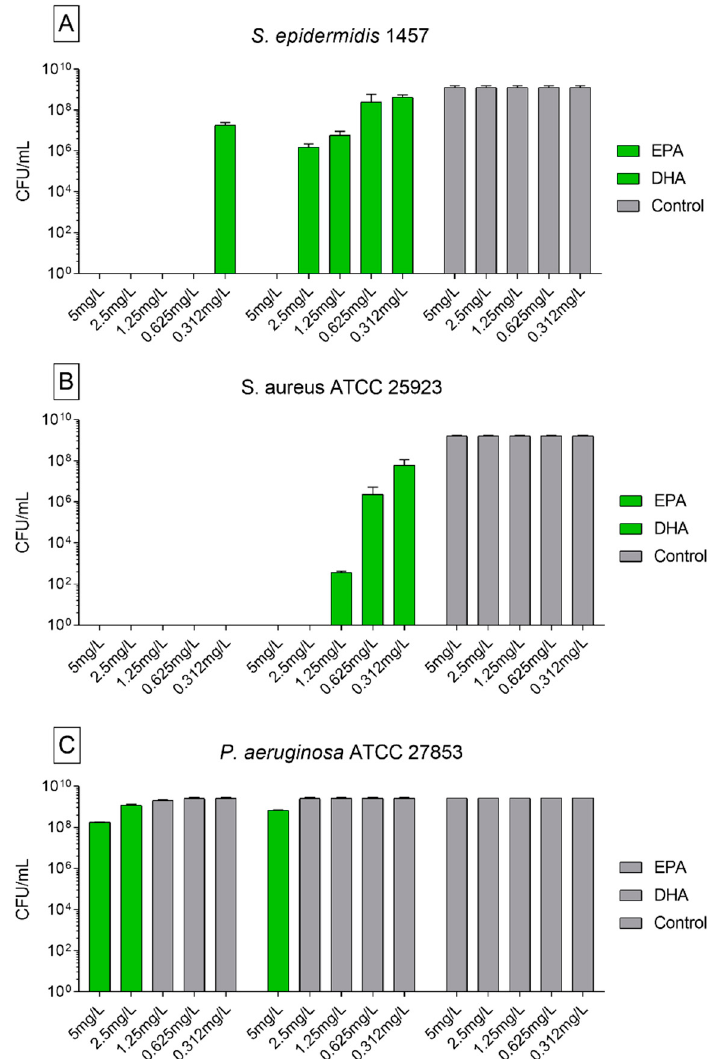
Figure 1. Activity of ω -3 PUFAs on planktonic cells analyzed by counting of colony forming units of reference strains incubated with EPA, DHA, and only with nutrient medium as control. Initial CFU inoculum (approximately 10 6 CFU). The data are stated as mean ± SEM. ( A ) S. epidermidis 1457; ( B ) S. aureus ATCC 25923; and ( C ) P. aeruginosa ATCC 27853. In green, values significantly different from control group S. epidermidis 1457 and S. aureus ATCC 25,923 ( p < 0.0001) and P. aeruginosa ATCC 27853 (5 mg/L p < 0.001 other concentrations p < 0.05). Statistically analyzed with two-way ANOVA and Turkey’s multiple comparison tests. All the tests were repeated twice and carried out in triplicates.